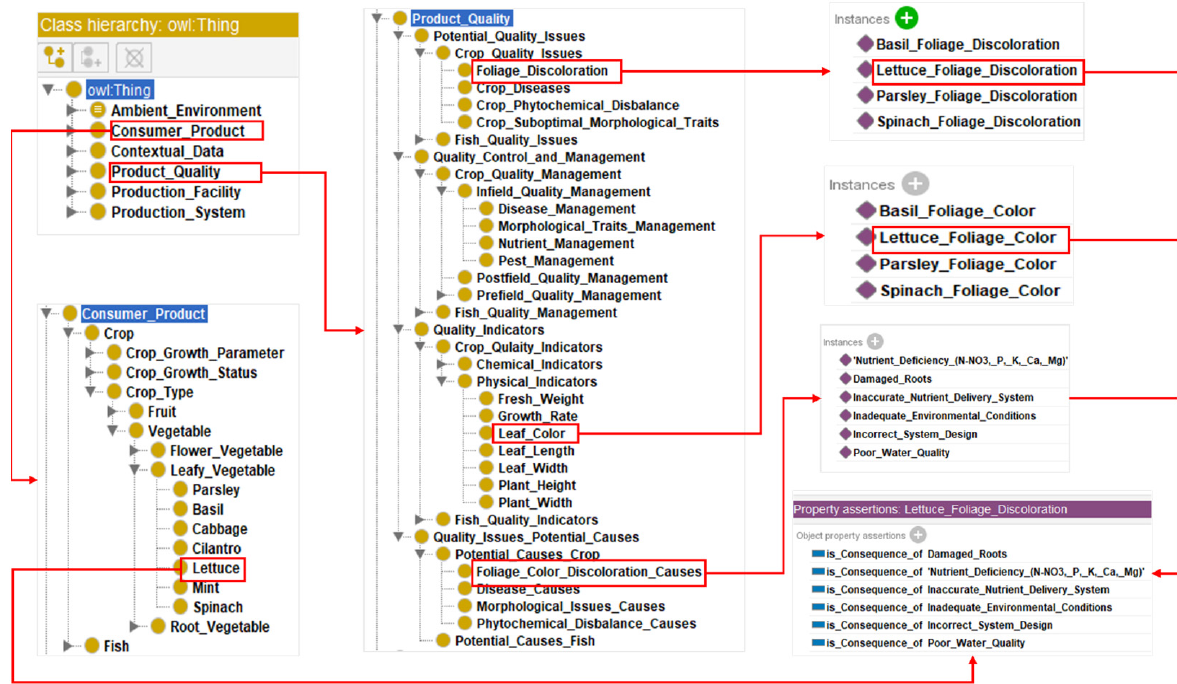
Figure 5. Ontology model showing classes, instances, and relationships between them.